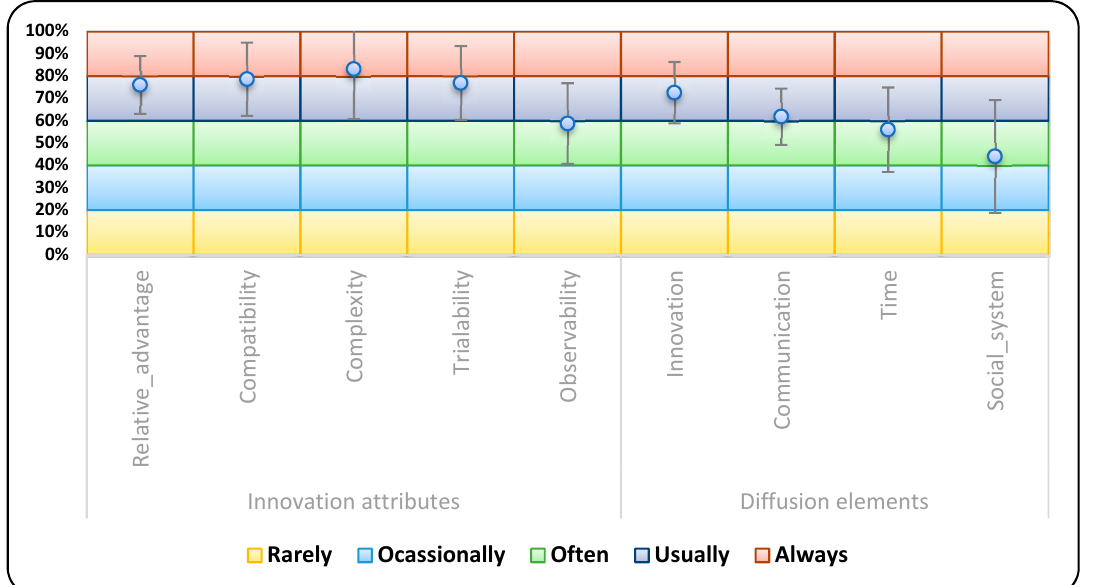
Figure 5. Rogers innovation attributes and diffusion element average scores: error bars depict the mean deviation from the average score.